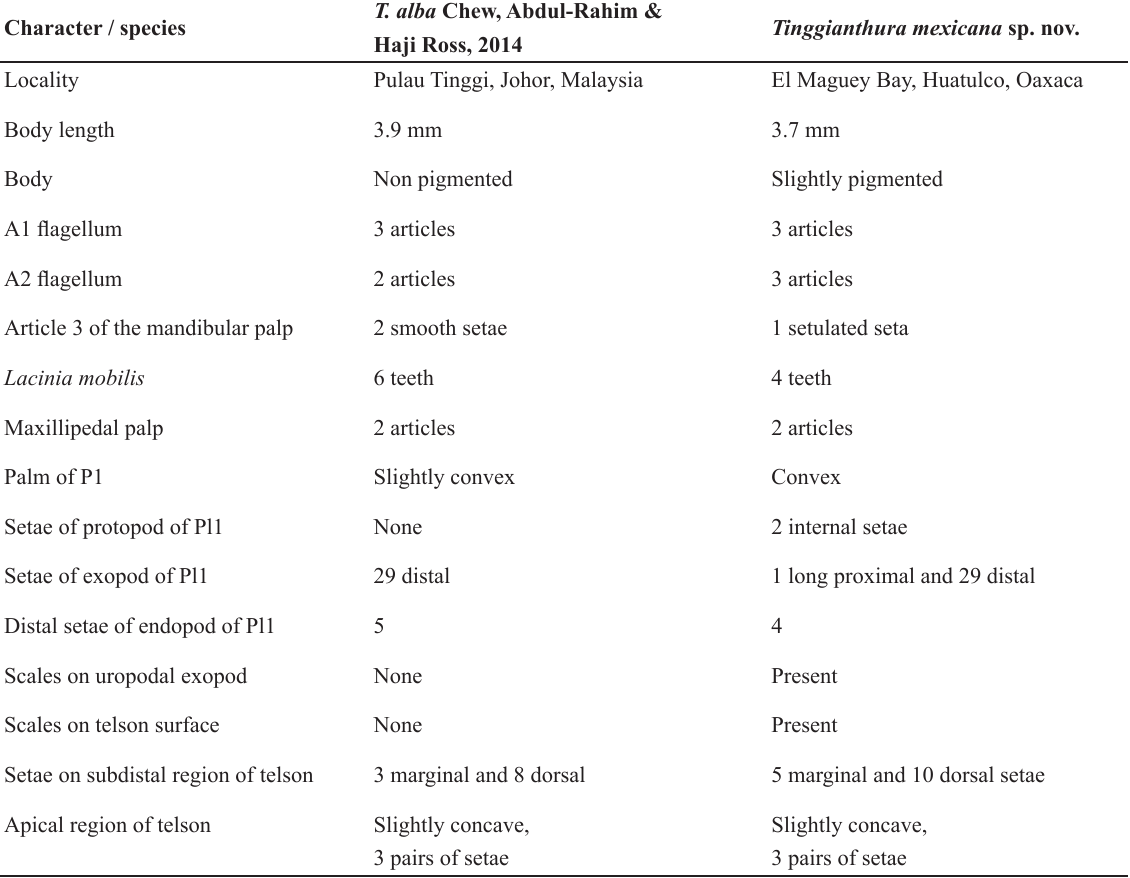
Table 3. Comparison between Tinggianthura alba Chew, Abdul-Rahim & Haji Ross, 2014 of Malaysia and Tinggianthura mexicana sp. nov. from Oaxaca,